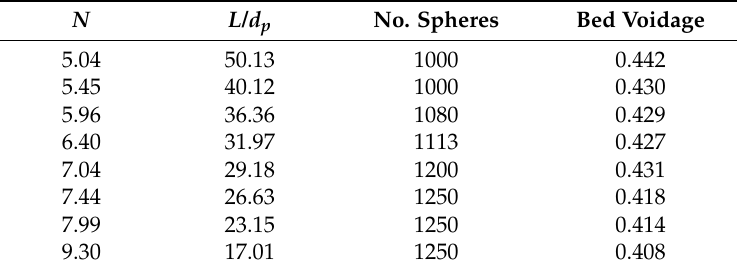
Table 1. Fixed bed configurations.